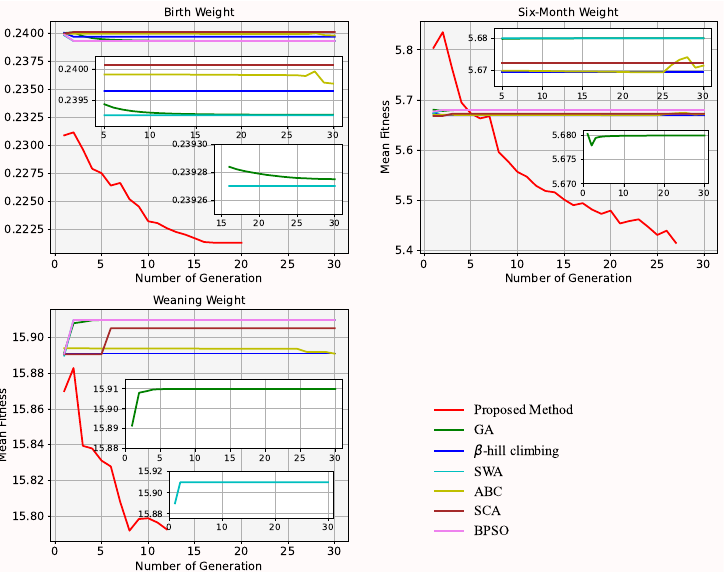
Figure 4. Mean fitness value of GA and the proposed method for the dataset of the body weights on three occasions.